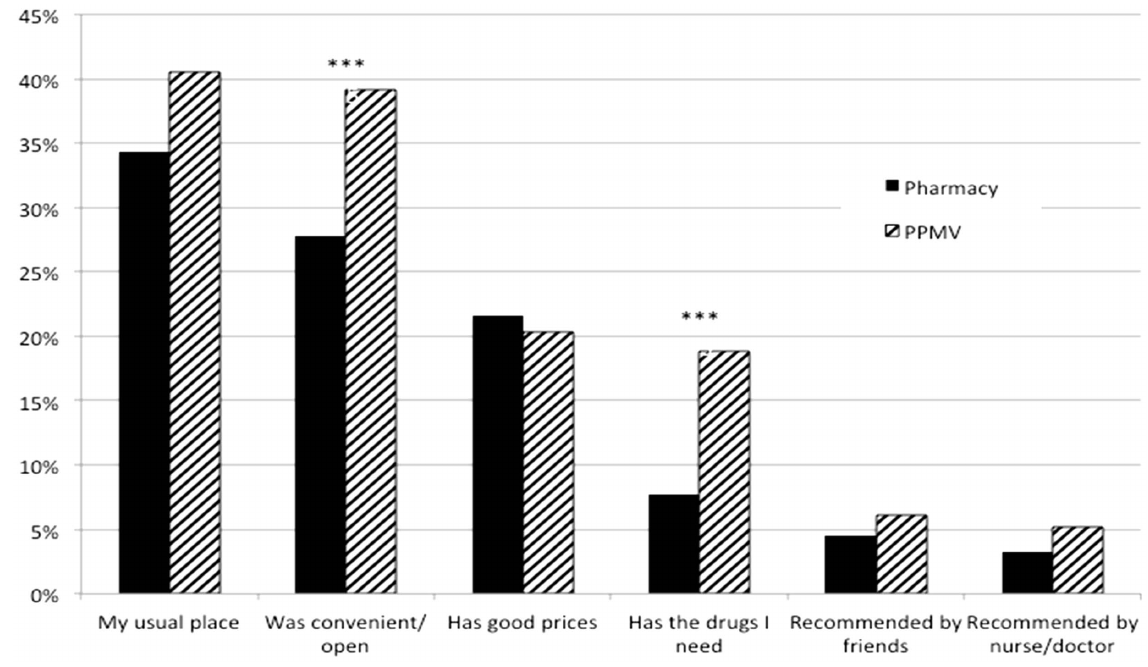
Figure 2. Reasons for choosing a drug shop (N=457). When asked for reasons why they chose the particular drug shop, most respondents stated reasons of habit and convenience (see Figure 2). A significantly higher percentage of participants at PPMVs said that the shop was convenient and had the drugs that s/he needed. In similar percentages, both types of outlets were cited for their prices. Note: *** p , 0.01, ** p , 0.05, * p , 0.1.